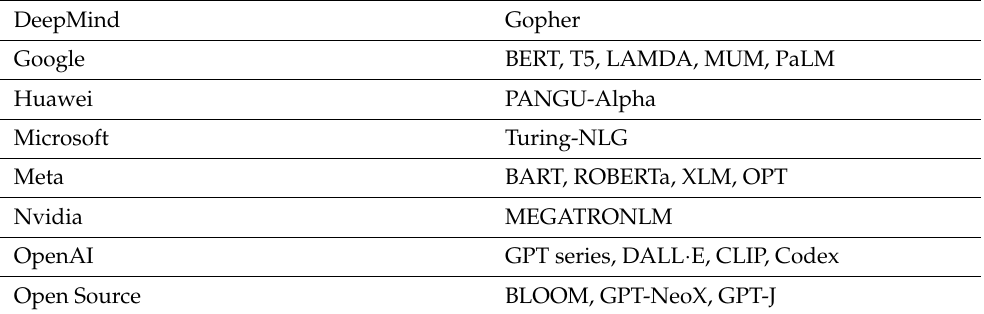
Table 4. Large Language Model Infrastructures deployed by technology enterprises.